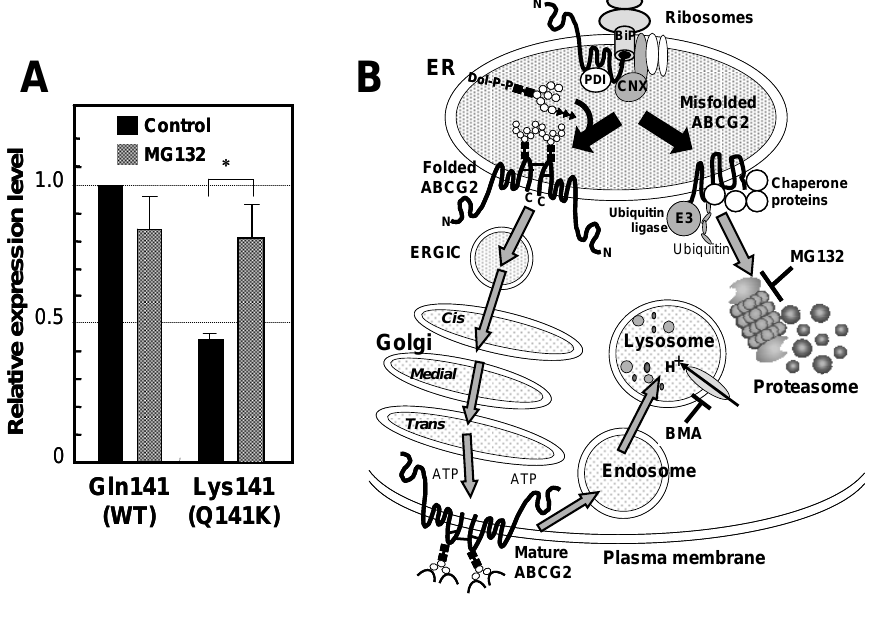
Figure 5. Effect of the SNP variant (Q141K) on the protein expression level and degradation of ABCG2. ( A ) The ABCG2 wild type (WT) protein has glutamine residue at amino acid position 141. To assess the effect of Q141K variant on the protein expression level, Flp-In-293 cells expressing WT and the Q141K variant were incubated in the absence or presence of MG132 (2 μ M) for 24 h. ABCG2 WT and Q141 variant proteins were analyzed by immunoblotting with the ABCG2-specific monoclonal antibody (BXP-21) after PNGase F treatment. The glyceraldehyde-3-phosphate dehydrogenase (GAPDH) protein level was analyzed by GAPDH-specific antibody. The signal intensity ratio (ABCG2/GAPDH) was normalized to the control level. Data are expressed as means ± S.D. in triplicate experiments [33]. ( B ) Correctly processed ABCG2 WT protein is destined to reach the plasma membrane and is then degraded by the endosome-lysosome pathway after remaining in the plasma membrane domain for a certain period. In contrast, the ABCG2 Q141K variant protein is recognized as a misfolded form and then undergoes ubiquitination-mediated proteasomal degradation. Bafilomycin A (BMA) and MG132 1 inhibit lysosomal and proteasomal degradation,